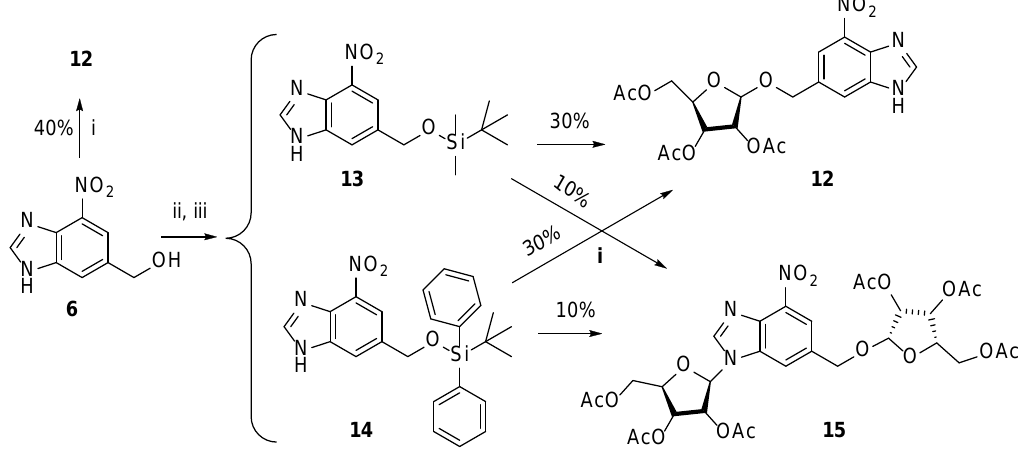
Scheme 2. Glycosylation reactions using the unprotected or protected heterocyclic base. Reagents and conditions: (i) dry acetonitrile, 1,2,3,5-tetra- O -acetyl- β - D-ribofuranose, tin (IV) chloride (1 M in dichloromethane (DCM)), room temperature (rt); (ii) dry acetonitrile, tert-butyldimethylsilyl chloride